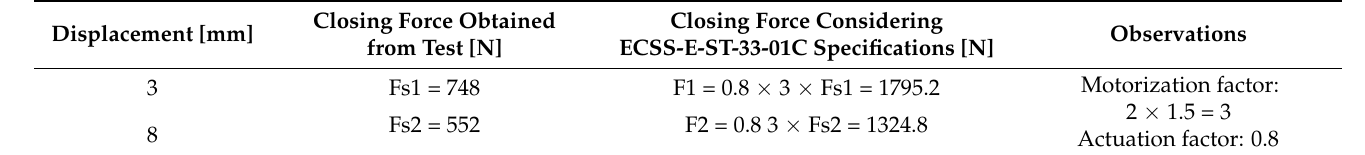
Figure 26. Measured reference values. Table 5. Mechanical press motorization calculus considering forces at − 40 ◦ C.